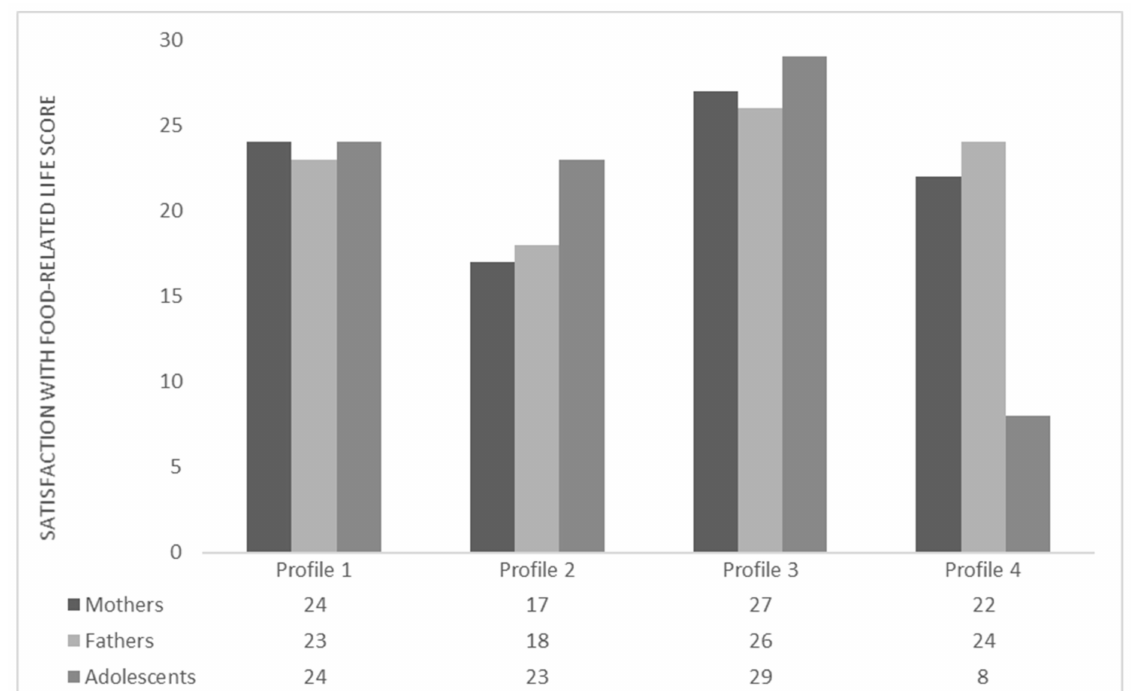
Figure 1. Profiles of two-parent families with adolescent children based on satisfaction with food- related life. Scores for satisfaction with food-related life were subjected to Dunnett’s T3 multiple comparisons